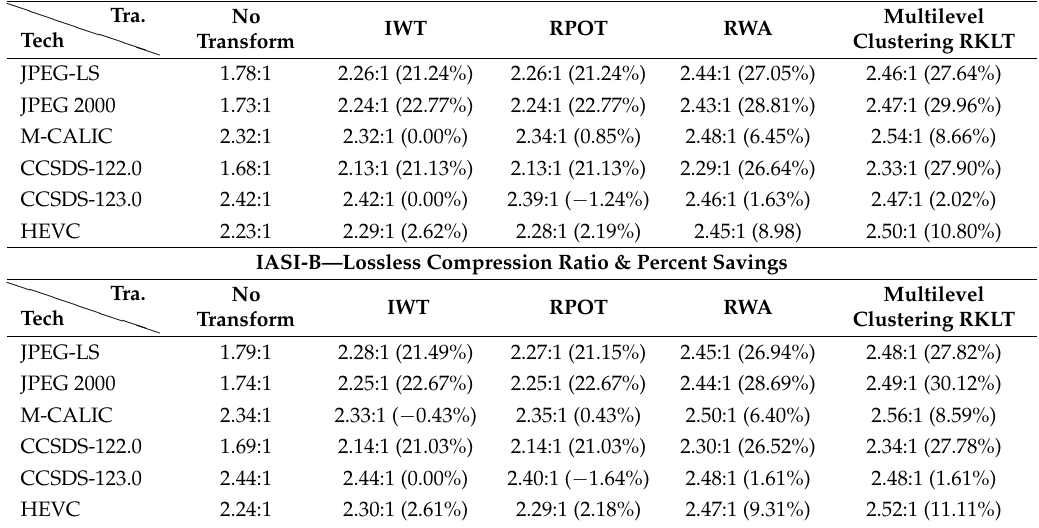
Table 8. Lossless compression of IASI L1C products. Results are reported in compression ratio (higher is better). Percent savings (higher is better) with respect to original technique are provided within